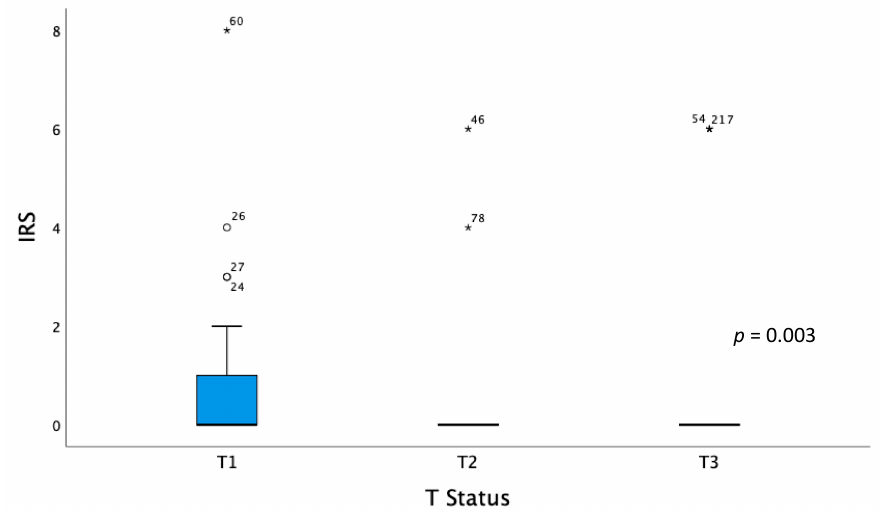
Figure 3. Boxplots for MSX1-staining in tumors with T1, T2, and T3 staging. The circle indicates values more than 1.5 box lengths from the 75th percentile. Asterisks indicate values which are more than 2 times the box length. Numbers at circle and asterisks indicate sample number.